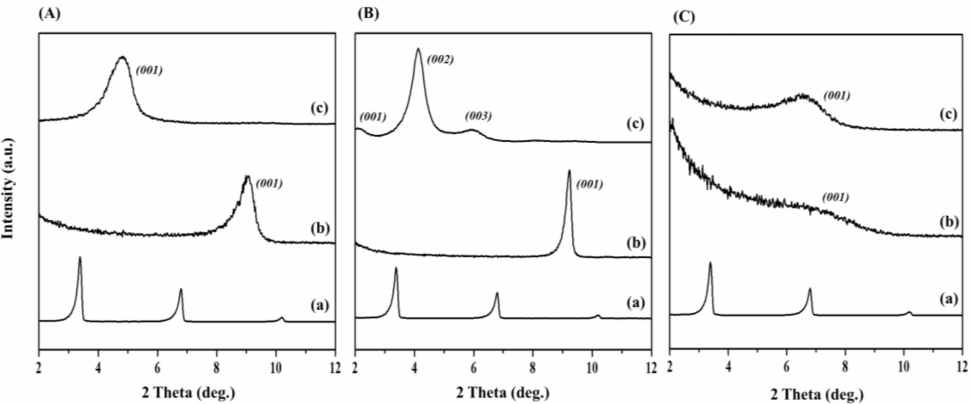
Figure 1. XRD patterns for ( A ) ( a ) CTA, ( b ) unmodified Mt, and ( c ) CTA-Mt; ( B ) ( a ) CTA, ( b ) unmodi- fied mica, and ( c ) CTA-Mica; and ( C ) ( a ) CTA, ( b ) unmodified Ht, and ( c )